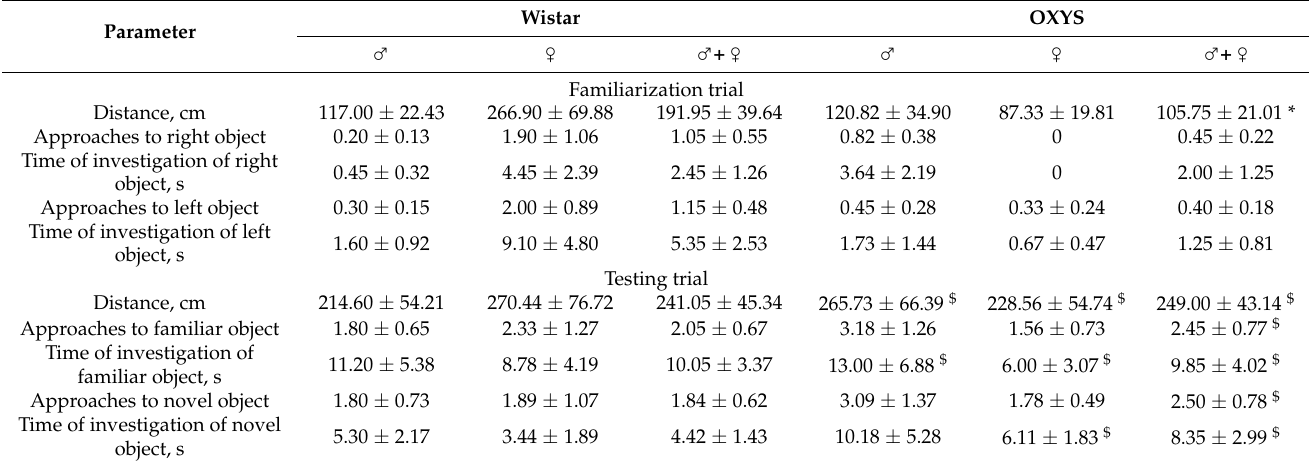
Table 6. Assessment of the learning ability in Wistar and OXYS rats in the NOR test (PND16). Wistar OXYS Parameter ♂ ♀ ♀ Familiarization